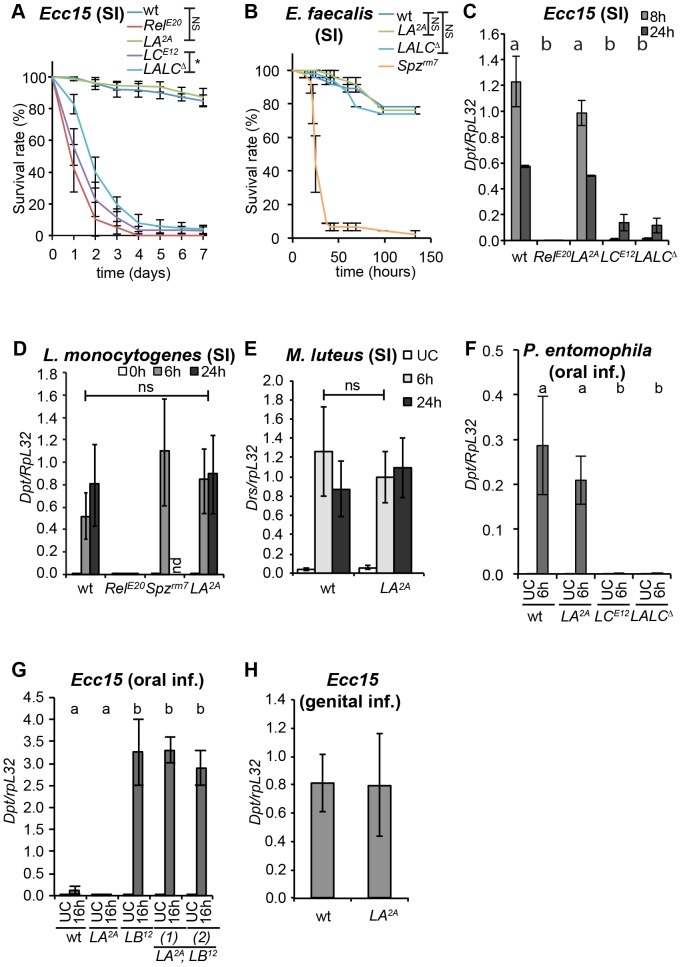

PGRP-LA is not required for the systemic immune response.
A,B. Survival analysis upon septic injury with Ecc15 in females (A) and E. faecalis in males (B). Full results of log-rank tests corrected with Bonferroni's method: in A, wt vs RelE20: **, wt vs LA2A: ns, wt vs LCE12: **, wt vs LALCΔ: **, LCE12 vs LALCΔ:*; in B, wt vs Spzrm7:**, wt vs LA2A: ns, wt vs LALCΔ: ns. C–E. RT-qPCR analysis of Dpt (C, D) and Drs (E) expression in whole females after septic injury with Ecc15 (C), L. monocytogenes (D), and M. luteus (E). F–H. RT-qPCR analysis of Dpt expression in whole females after oral infection with P. entomophila (F) or Ecc15 (G), and in males 6 h after genital infection by Ecc15 (H). In G, H, data are shown as a ratio of LBΔ 16 h (G) and wt (H). In C–G, data were analyzed by 2-way ANOVA with Bonferroni's multiple comparison post-tests (in C, F, G, a and b groups are statistically different in infected flies: *, *** and *** respectively. In D, wt vs RelE20 (24 h): **, wt vs LA2A: ns (Spzrm7 is not included in the tests). In F and G, no significant differences were observed in unchallenged flies). In B, C, G, H, data are the mean of two repeats and error bars indicate data variation. In A, D, E, data are the mean of three independent repeats and error bars indicate standard errors. In F, data are the mean of 8 repeats from two independent experiments and error bars indicate standard errors. wt – wild type; LA2A – PGRP-LA2A; LCE12 – PGRP-LCE12; LALCΔ – PGRP-[LA, LC]Δ; RelE20 – RelishE20; Spzrm7 – Spätzlerm7. LBΔ – PGRP-LBΔ; LA2A, LBΔ (1) and (2) are two strains derived from independent recombination events between LA2A and LBΔ; nd – no data; ns: non significantly different; *,**,*** show statistical differences with p<0.05, p<0.01 and p<0.001 respectively.